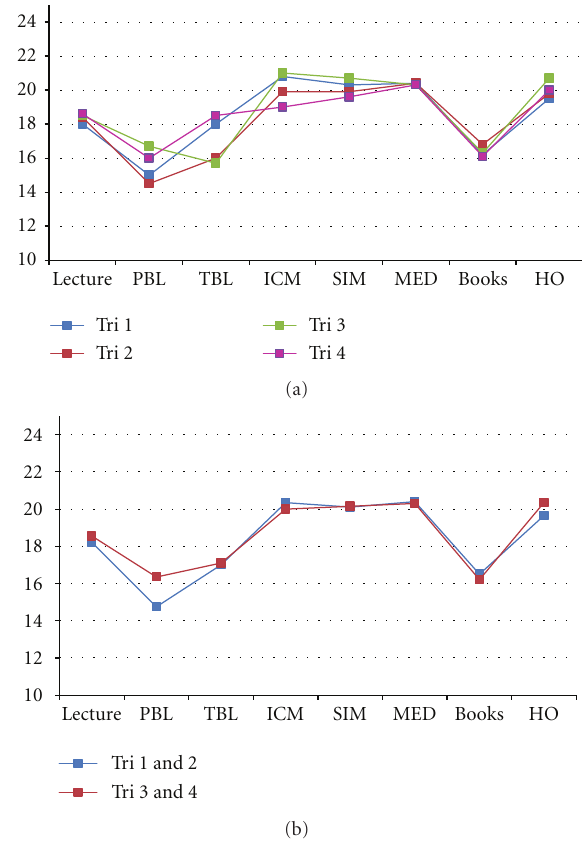
Figure 3: Di ff erences between students in the four trimesters. The most significant di ff erences are higher PBL scores in trimesters 3 and 4 compared to trimesters 1 and 2 ( d = 2 . 45, P < . 001) and lower scores for ICM practicals in trimester 4 compared to trimesters 1–3 ( d = 2 . 20, P < .